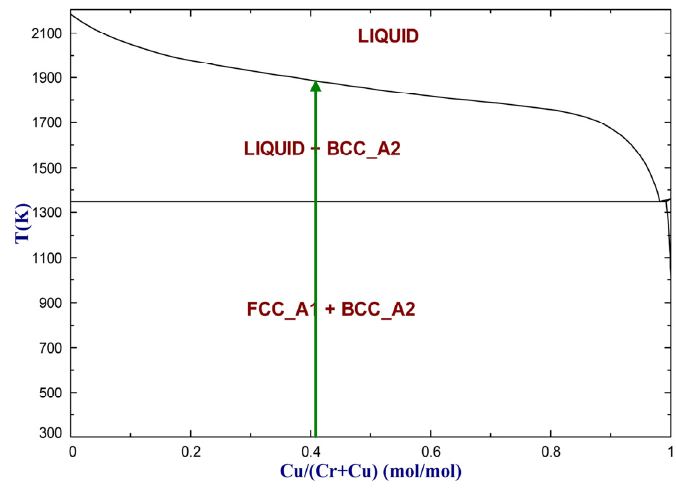
Figure 3. Binary phase diagram of Cr and Cu from FactSage 7.3 databases [33].